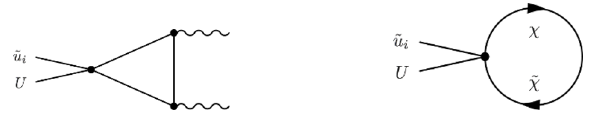
Figure 4 . Imaginary contribution to the mass of the vector-like quarks due to the Z NB mass, m . χ